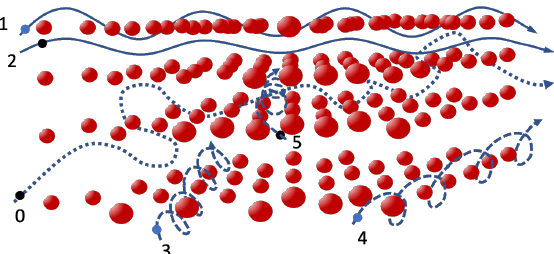
Figure 3. Various channeling regimes for positively and negatively charged particles in crystals. 0—amorphous orientation; 1—planar orientation for a negative charge; 2—planar orientation for a positive charge; 3 and 4—axial orientation for a negative charge; and 5—axial orientation for a positive